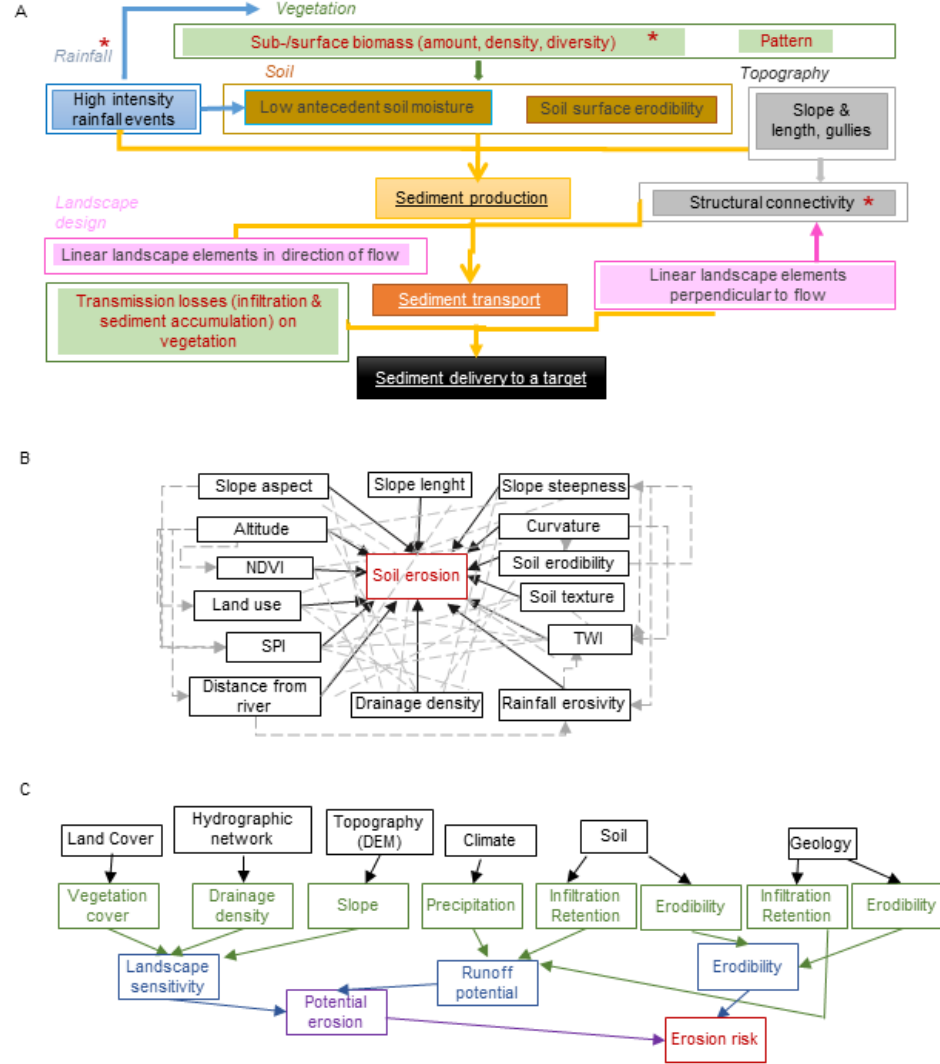
Figure 2. Example concepts of relationships between dominant factors leading to detachment of sediment, sediment transport and delivery to a target: ( A ) Approach applied in this study. Sediment transport is here in focus, rather than runoff generation only. Simplifications are made for sediment detachment in transport routes (e.g., gullies, permanent streams). Factors-italics, sub processes are underlined. Red asterisk indicates variables considered in this study. ( B ) Complex relationship structure between controlling factors to evaluate the susceptibility to sediment production (soil erosion). NDVI, normalized di ff erence vegetation index; SPI, stream power index; TWI, topographic wetness index. Reproduced with permission from [43] published by Wiley, 2018. ( C ) Controlling factors of erosion risk (reproduced with permission from [16] published by Elsevier, 2006).